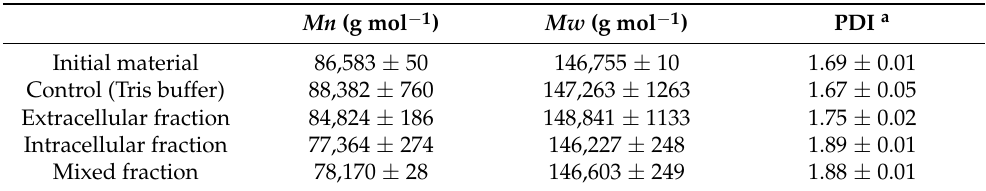
Table 2. Molecular weight and number ( Mw , Mn ) and polydispersity index of PU material after treatment with extracellular and intracellular protein fractions of A. mediterranei ISP5501.